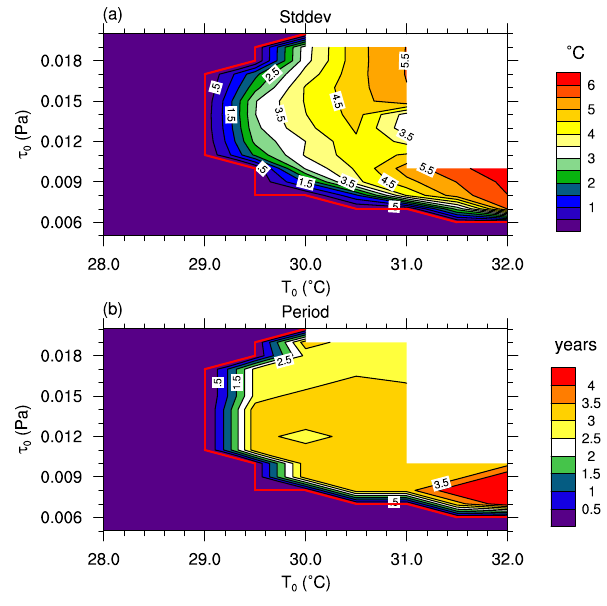
Fig. 5. Effects of changing the external wind stress τ 0 and the ra- diation equilibrium temperature T 0 on the ENSO variability of the tropical Pacific. The red line in both plots is the same as in Fig. 4 and divides the area into regions with and without ENSO variability. In the white areas of the plots, the model yields unphysical results. (a) The ENSO amplitude (in ◦ C) measured as the standard devia- tion of SST in the cold tongue as a function of τ 0 (in Pa) and T 0 . (b) The ENSO period (in years) as a function of τ 0 (in Pa) and T 0